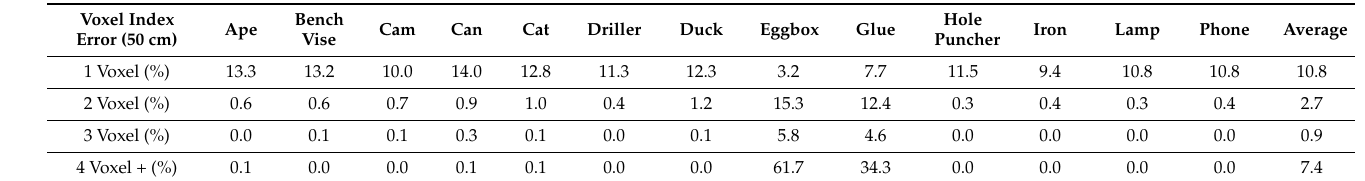
Table 7. Distance error comparison of 6D pose estimation via the EfficientPose network according to VPS Voxel Size.